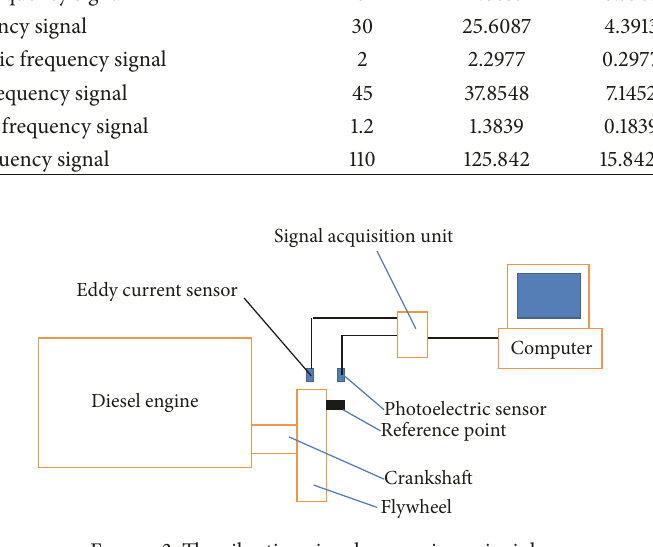
Figure 3: The vibration signal measuring